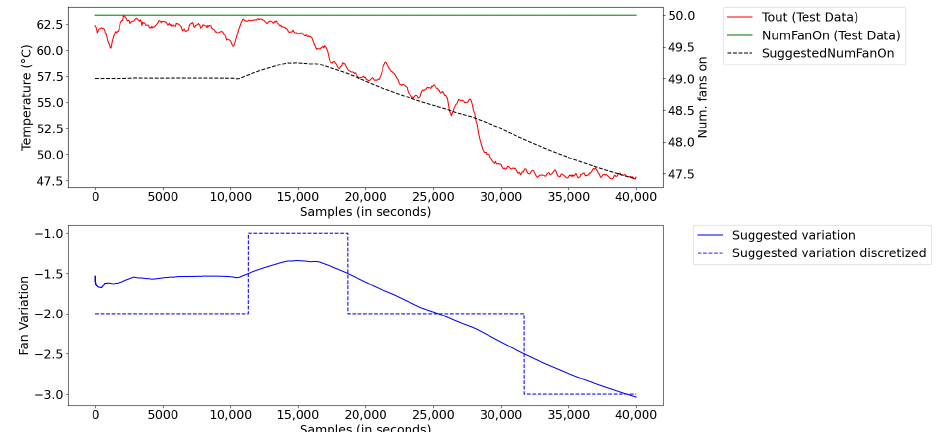
Figure 22. Optimization of number of fans for continuous